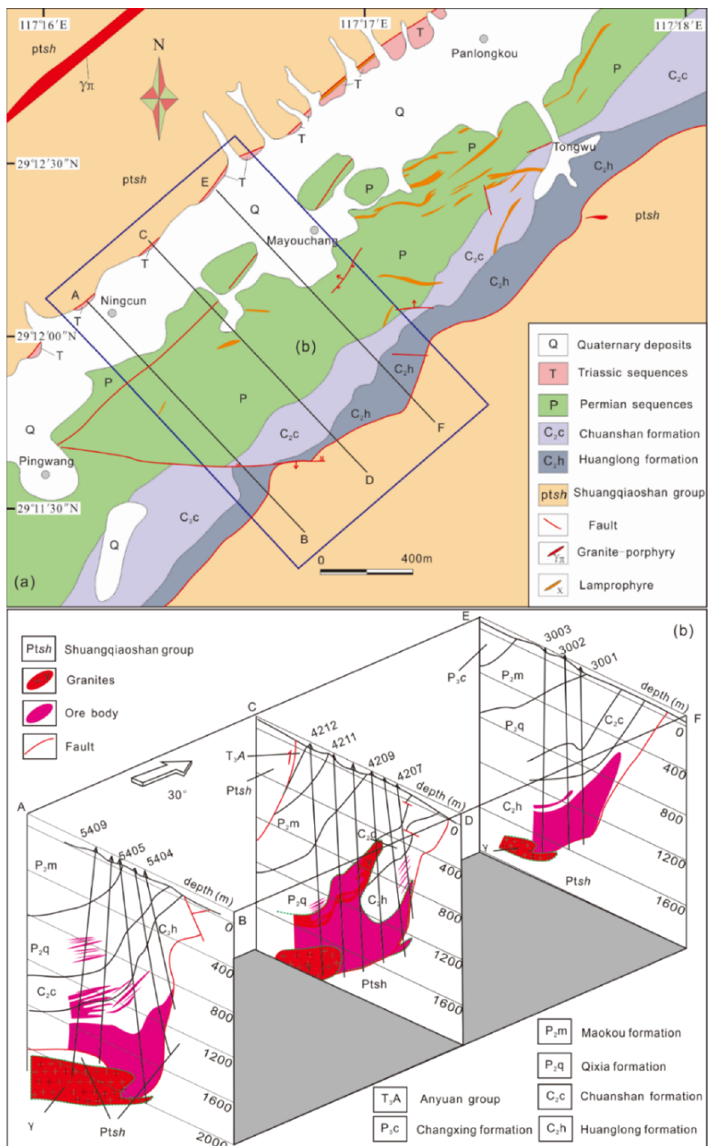
Figure 2. Simplified structural map of Jingdezhen showing ( a ) sample and stratigraphic section locations of this study, and ( b ) a 42–line stratigraphic section of the Zhuxi area.